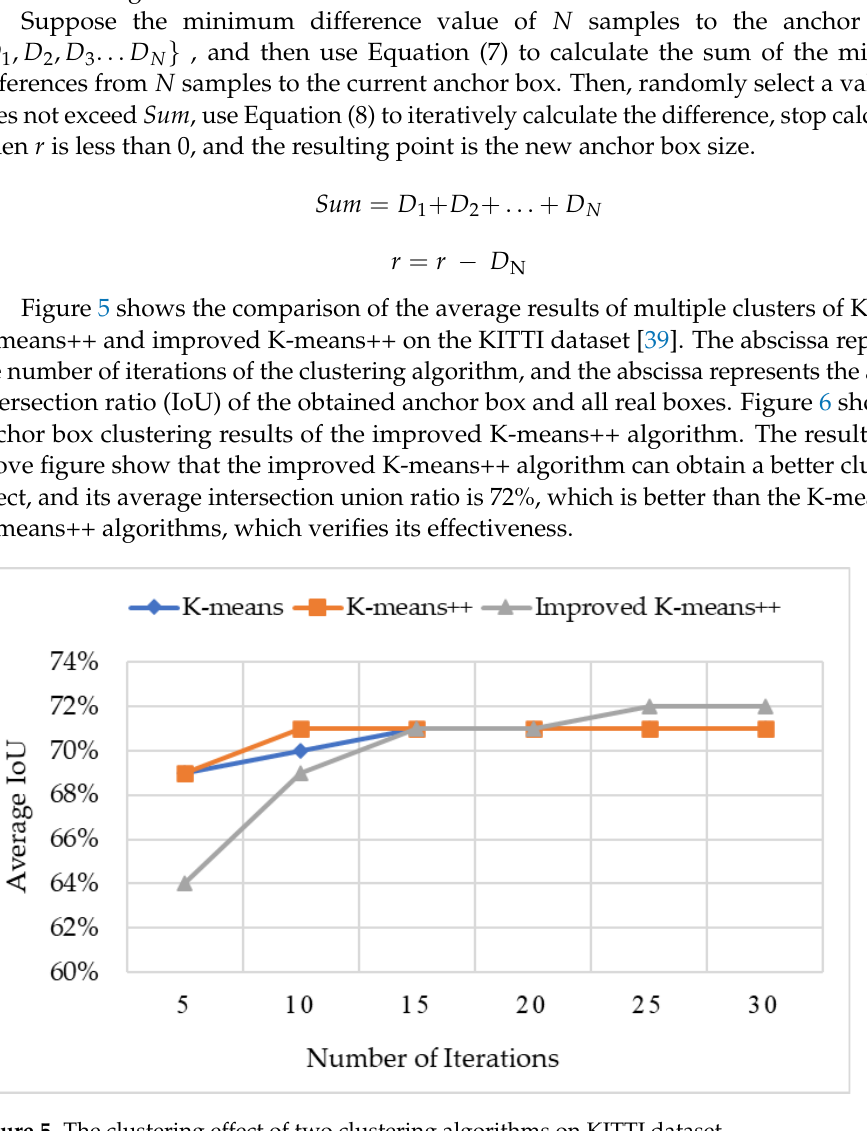
Figure 5. The clustering effect of two clustering algorithms on KITTI dataset.